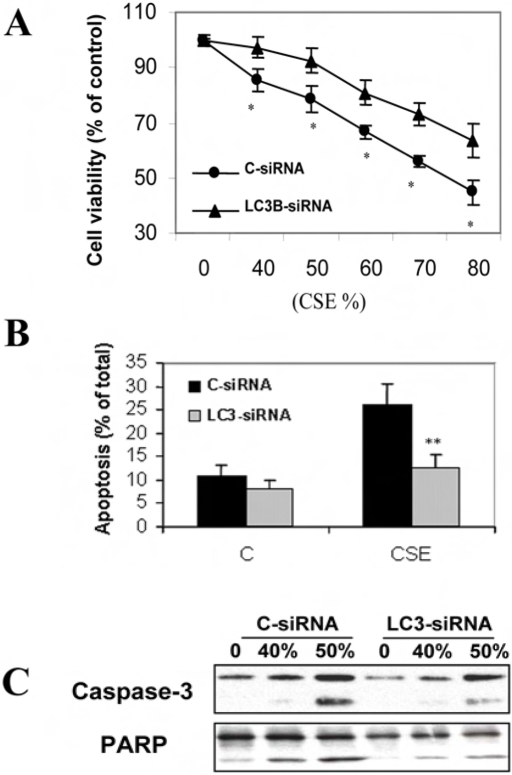
Relationship of autophagy to epithelial cell death.(A–C) Beas-2B cells were pretreated with C-siRNA or LC3-siRNA for 48 h followed by exposure to the indicated concentrations of CSE for an additional 24 h. Cells were then subjected to MTT assay (A), Annexin-V staining (B) or Western blot analysis (C). (A) LC3-siRNA attenuated CSE-induced cytotoxicity in Beas-2B cells. (B) LC3-siRNA inhibited CSE-induced apoptosis in Beas-2B cells. (C) LC3-siRNA attenuated CSE-induced caspase-3 activation and PARP cleavage. (A, B) Data represent mean±SD, (n = 3, * indicates P<0.05 and ** indicates P<0.01 compared with the corresponding control data).